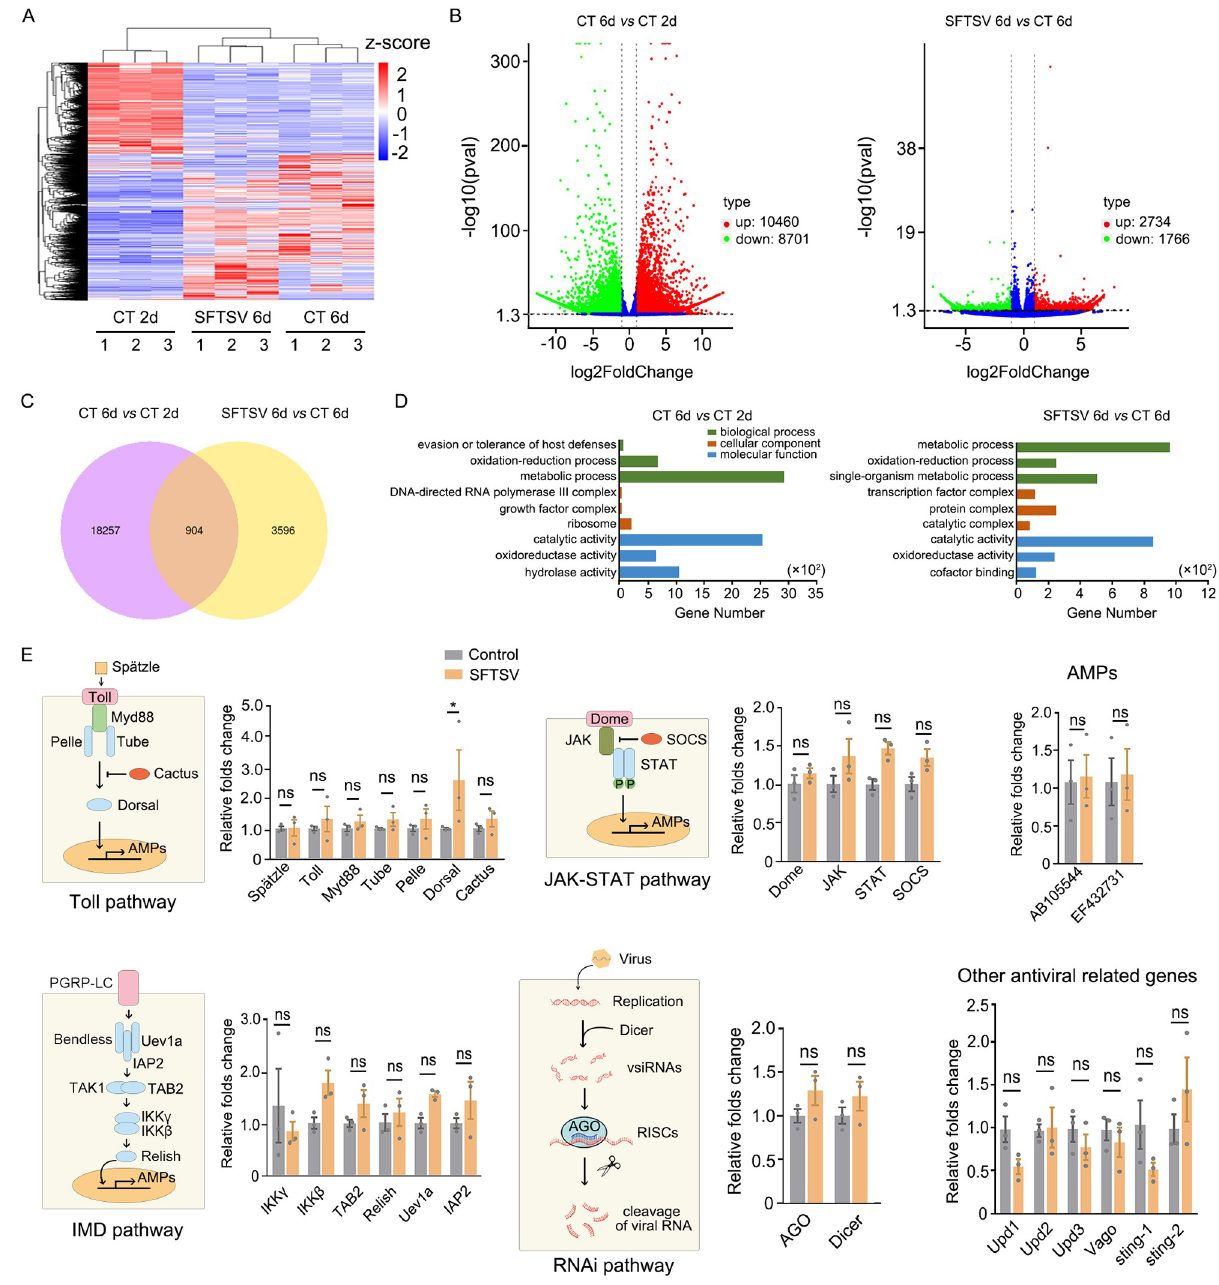
Fig 2. The status of immune response induced by SFTSV infection in H . longicornis ticks. (A) Hierarchical clustering of differentially expressed genes (DEGs) (log2|fold change| > = 1, p-value < 0.05) from CT 2d, CT 6d and SFTSV 6d transcriptomes from H . longicornis . The scale represents z- score of gene FPKM (Fragments Per Kilobases Million). Nymphs had a blood meal for 2 days on mock-infected or SFTSV-infected suckling mice. For control (control treatment, CT) or infected ticks (SFTSV), the time was marked as 2d when ticks were removed from mice. If removed ticks were incubated for another 4 days, the time was marked as 6d. (B) Volcano plots show DEGs from CT 6d vs CT 2d and SFTSV 6d vs CT 6d. (C)Venn diagram of unique and common DEGs between CT 6d vs CT 2d and SFTSV 6d vs CT 6d. (D) Top Gene Ontology (GO) terms of up-regulated DEGs from CT 6d vs CT 2d and SFTSV 6d vs CT 6d. (E) The differential expression levels of genes from the primary innate immune pathways (Toll, IMD, JAK/STAT, RNAi, and other antiviral related genes) after control-treated and SFTSV infection at 6 days detected by RT-qPCR. The relative fold change of mRNA was calculated by ΔΔ Ct method and normalized using control-treated sample. Significance was determined by ANOVA with Dunn’s tests. ns: not significant. � P < 0.05.